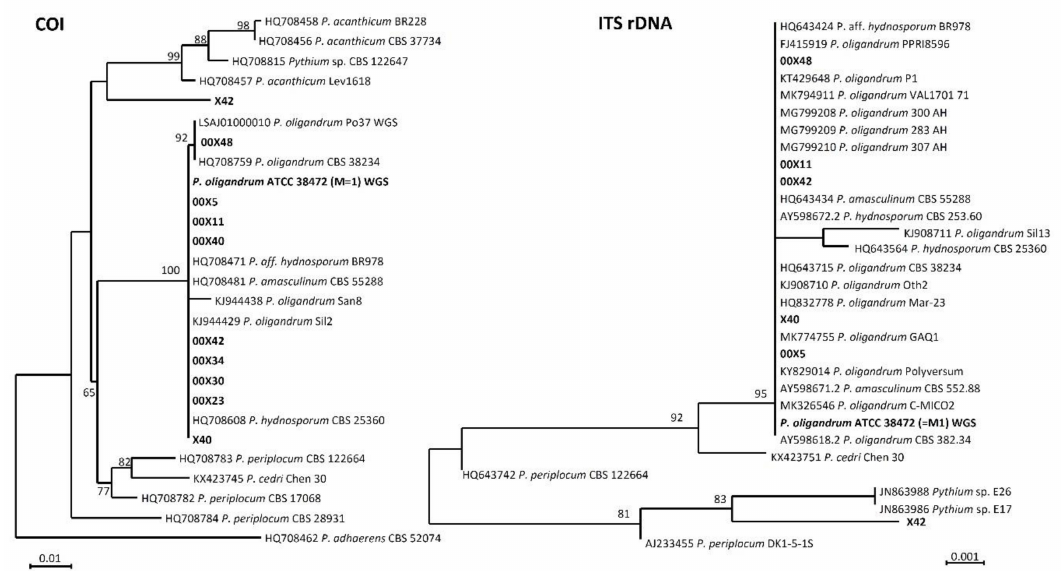
Figure 1. Maximum likelihood (ML) tree of Pythium spp. based on COI (left) and ITS rDNA (right) barcode genes. The bootstrap values are indicated at the nodes. The strains used in this study are printed in bold. The tree was rooted with P. adherens HQ708462 and P. periplocum AJ233455, respectively.